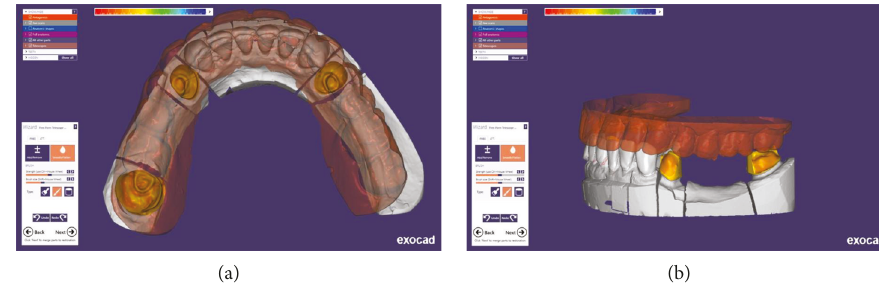
Figure 4: Mandibular restoration digital design: (a) occlusal view and (b) lateral view.